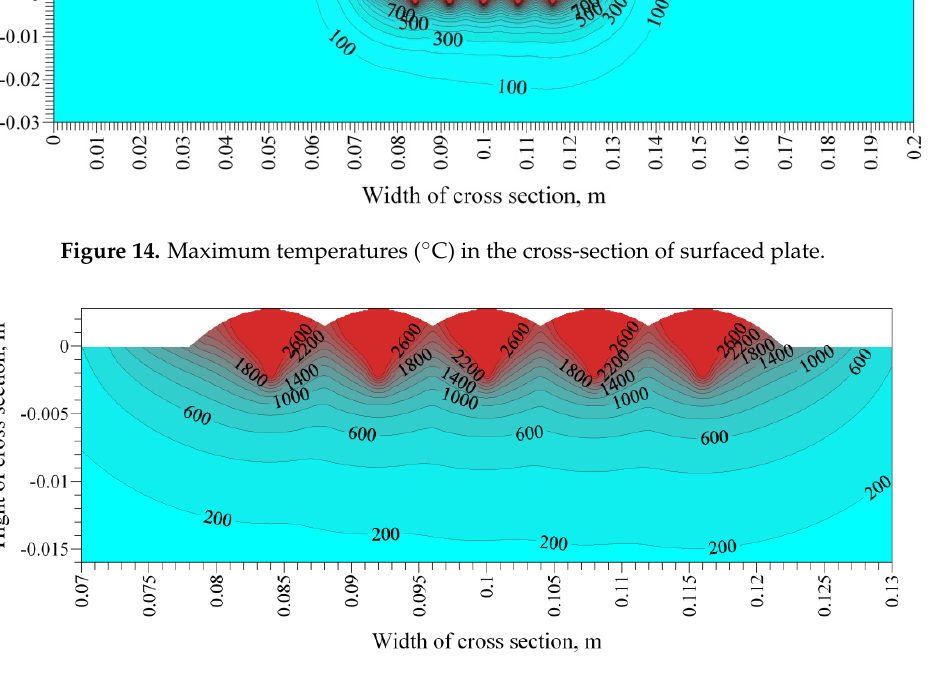
Figure 15. Maximum temperatures (°C) in the middle part area of cross ‐ section.